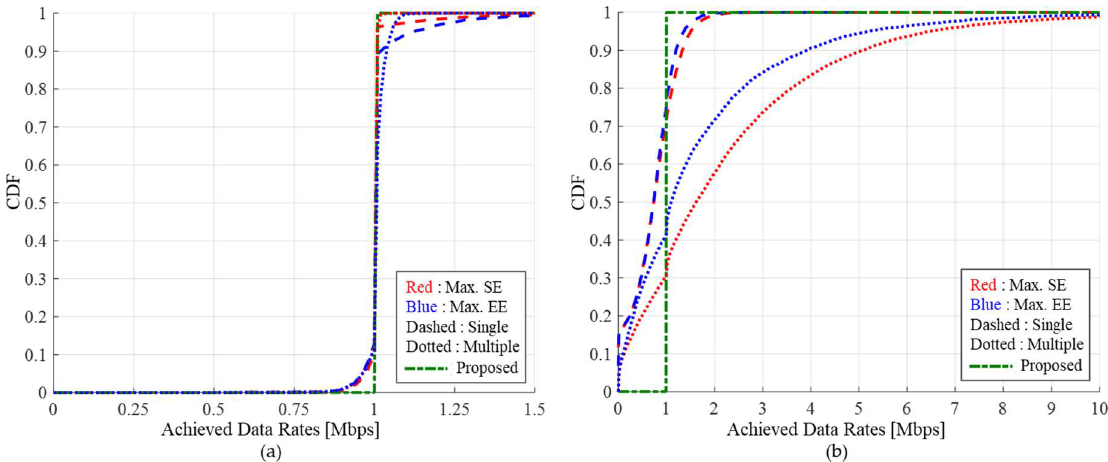
Figure 7. CDFs of the achieved data rate for the proposed rate guarantee scheme and the previous schemes when N = 10 . ( a ) Achieved data rate of CUs, ( b ) achieved data rate of device-to-device UEs (DUs). Table 3. Comparison of